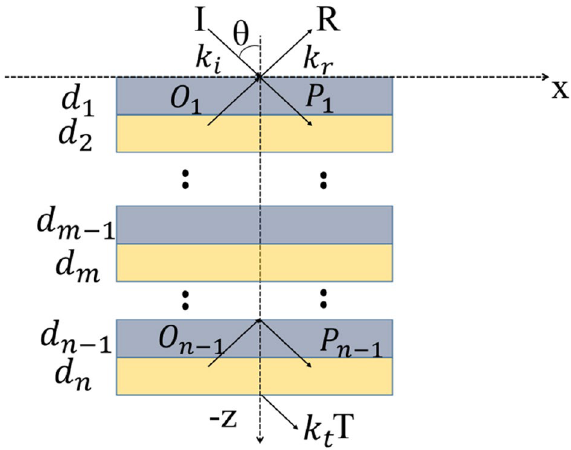
Figure 3. Schematic of the multilayers showing the propagation of light in the various single layers. A high value of transmission, T , is the primary aim for this